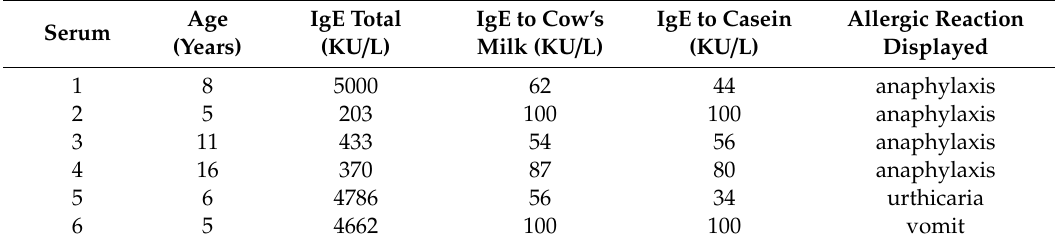
Table 1. The clinical features of the allergic individuals enrolled in this